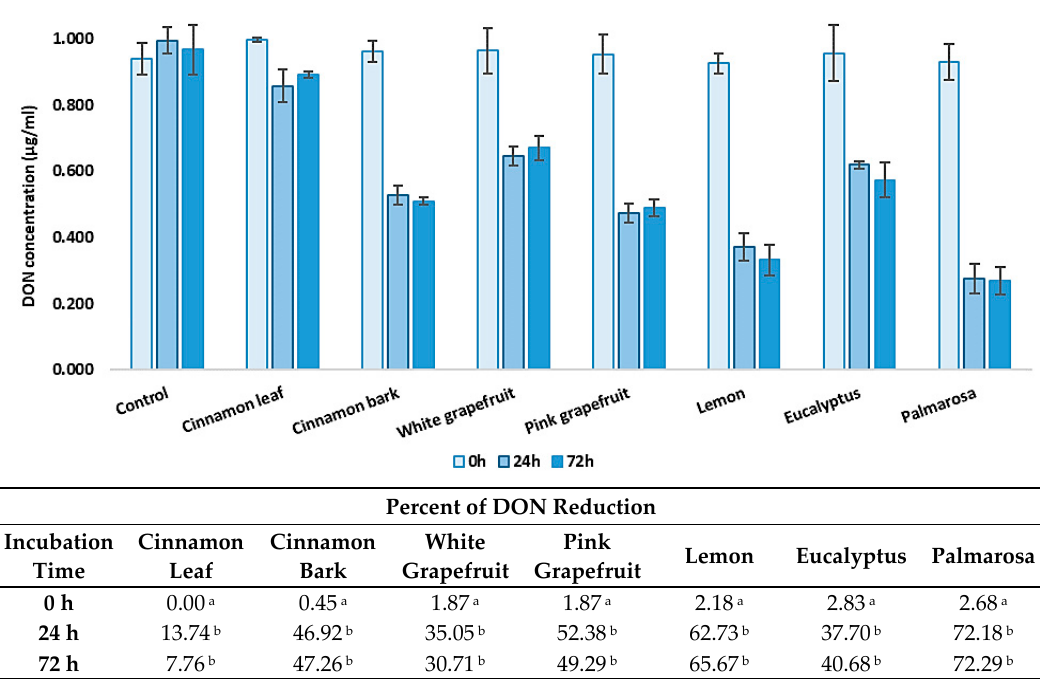
Figure 2. Reduction of DON concentration by essential oils at different incubation time. The experiment was conducted up to 72 h at 20 ° C. Data were analyzed by Tukey’s test at p < 0.05 ( a , b — significantly different in column).